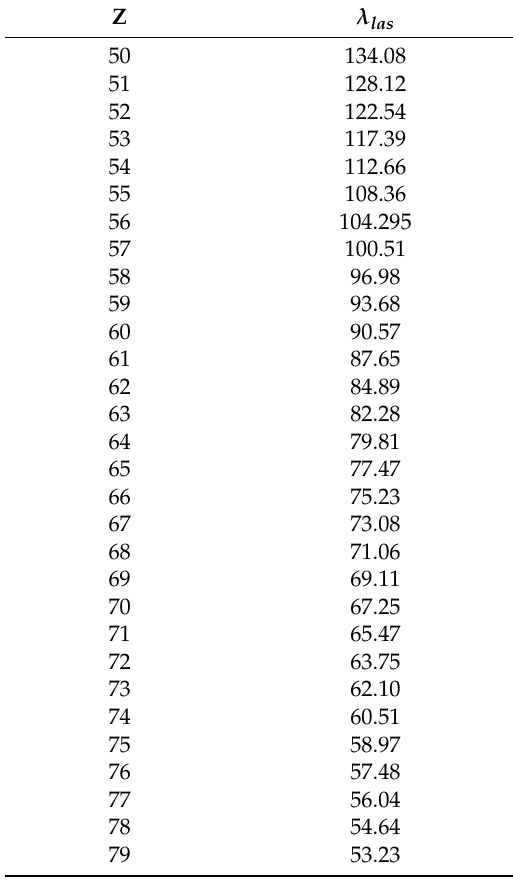
Table 2. Wavelengths ( λ las , Å) of the 3d 3/2 4f 5/2 ( 1 P 1 )–3d 3/2 4d 3/2 ( 1 P 1 ) SPP laser transitions in Ni-like sequence calculated by RPTMP. Z λ las